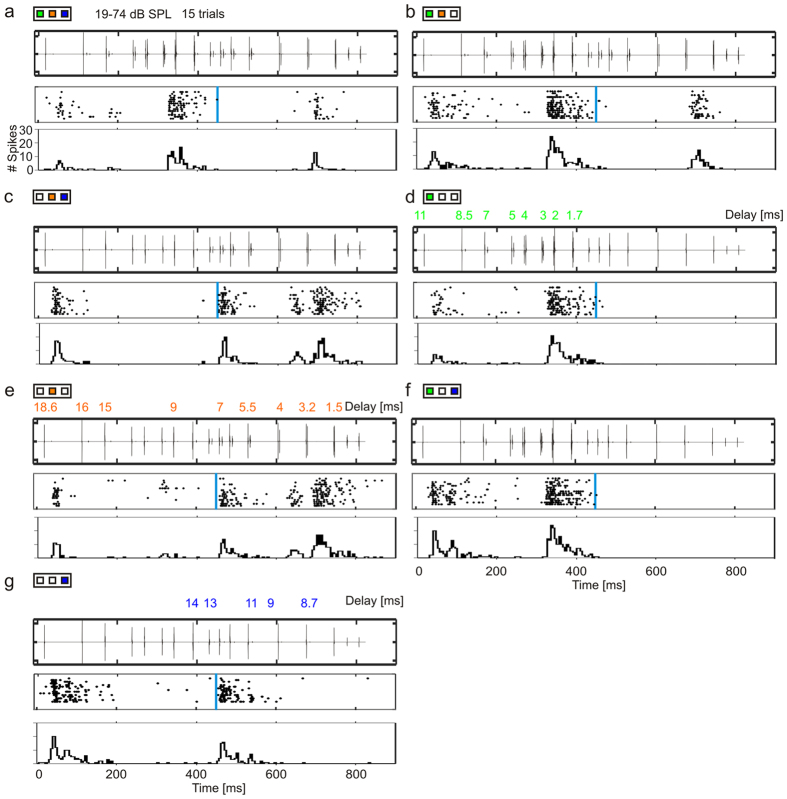
Responses to multiple- and to different single- and dual-object sequences.For each stimulus condition the oscillogram of the acoustic sequence (top plot), the raster plot, and post-stimulus time histogram (PSTH; binsize = 5 ms) of the neuronal response from a multi-unit is shown (middle and bottom plots). Vertical blue lines indicate the time point where echoes from object A are absent due to the bat leaving that object behind in the flight trajectory. Colored numbers above the oscillograms in (d,e,g) indicate some delays that are presented at that particular time point of the corresponding sequence. (a–g) Response to object ABC (a), AB (b), BC (c), A (d), B (e), AC (f), and C (g) sequences. Note that after passing object A, stimulations in (a,c,b,e) as well as stimulations in (f,g) are the same.